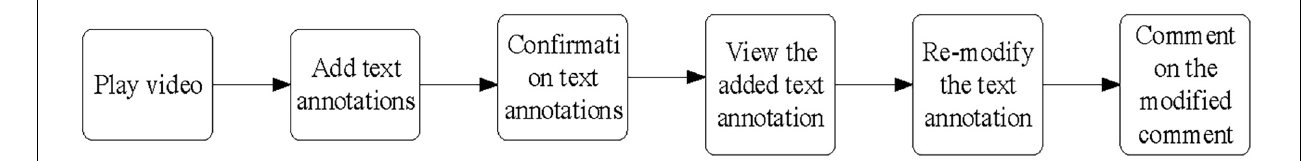
FIGURE 5 | Operation process of participatory video eye movement control experiment.